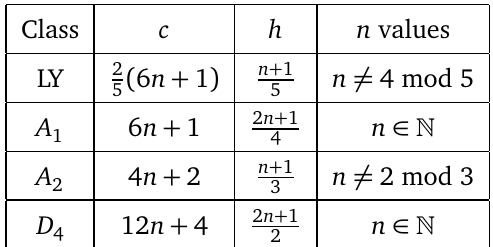
Table 1: Complete list of quasi-characters for (cid:96) =